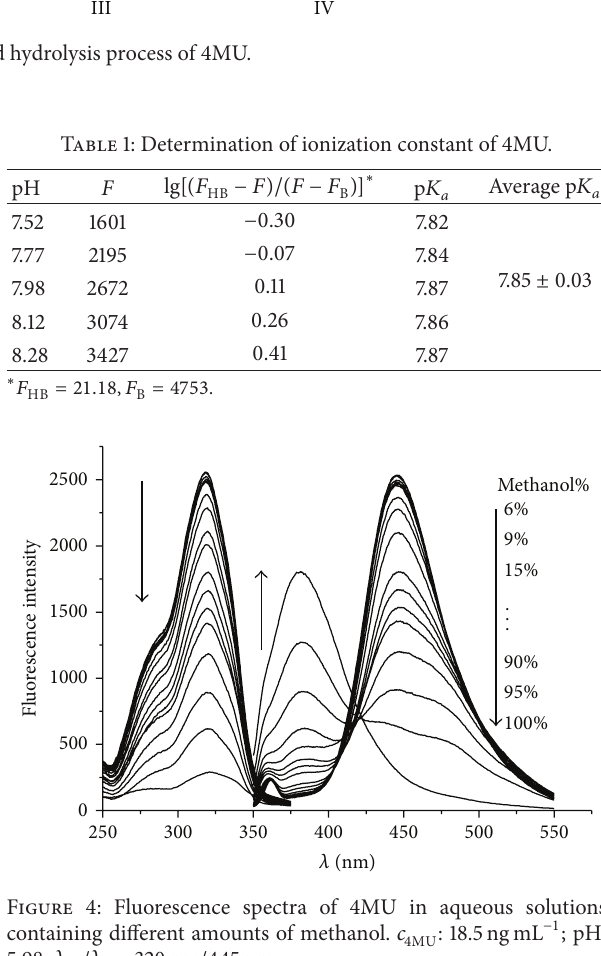
: 18.5 ng mL −1 ; pH: MU